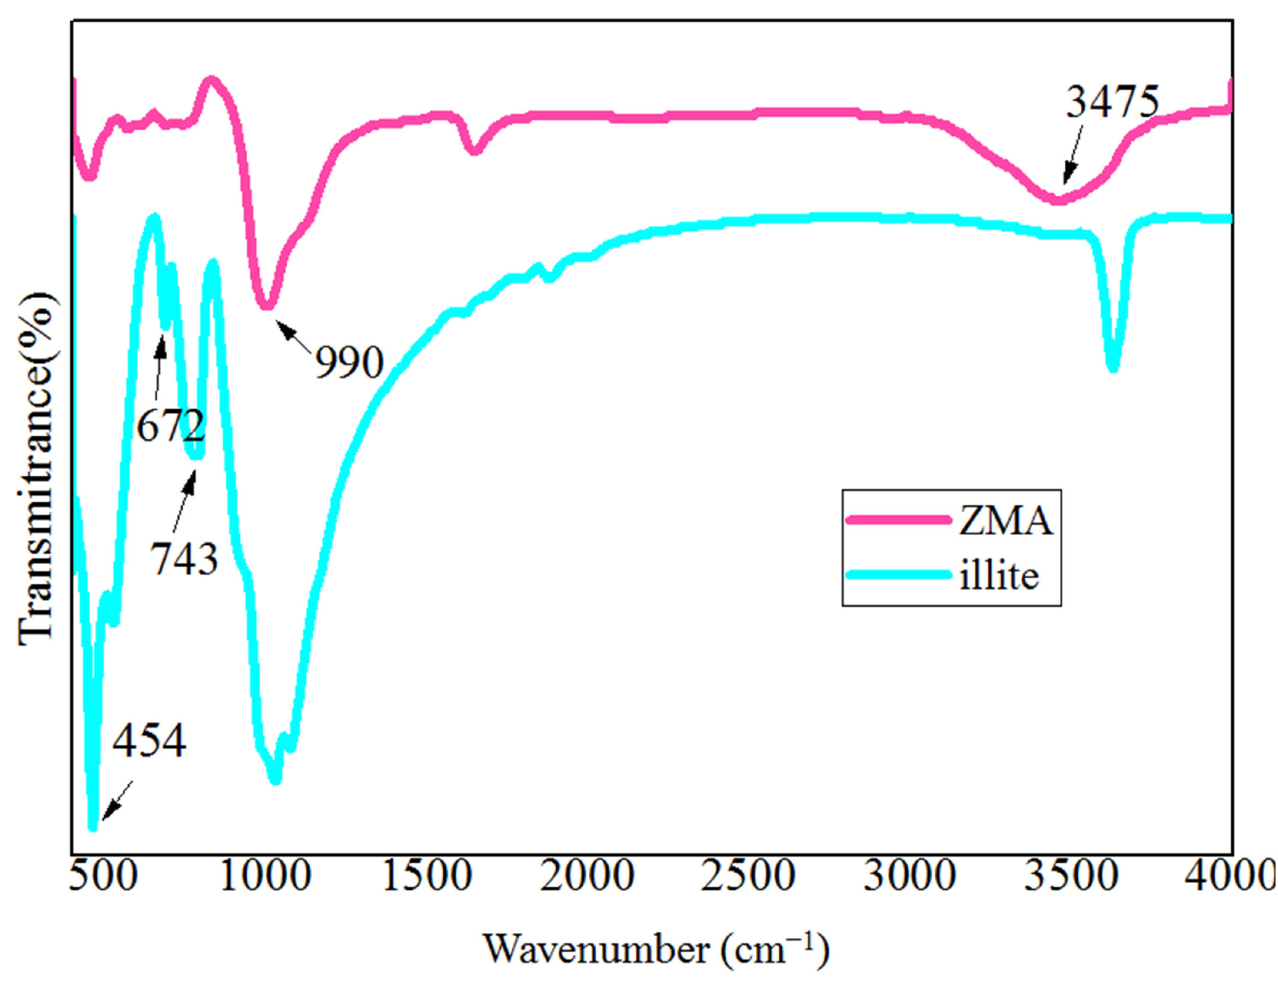
Figure 3. FTIR spectrums of the illite and ZMA.